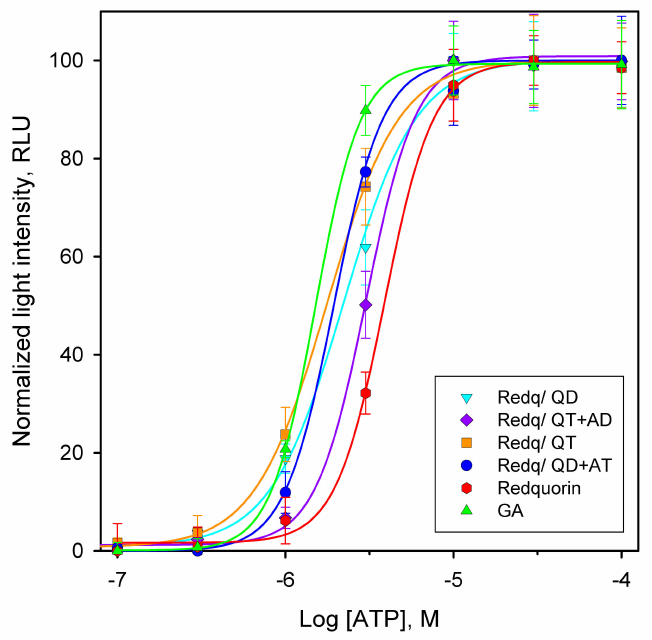
Figure 6. Dose–response curves for activation of endogenous P2Y2 receptor with ATP in CHO cells stably expressing the indicated Ca 2 + sensor variants. The light intensity was measured by integration of the bioluminescence signal for 60 s. Each point is the mean ± SD of eight